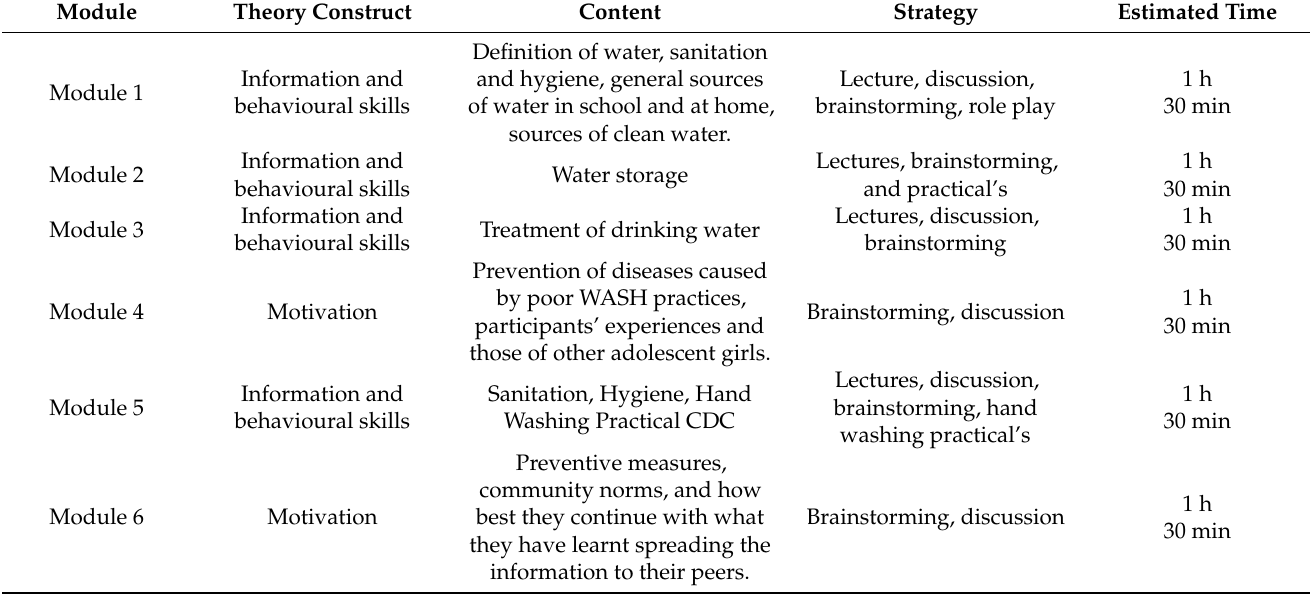
Table 2. Illustration of WASH Health Education Intervention Module by Theory Construct and